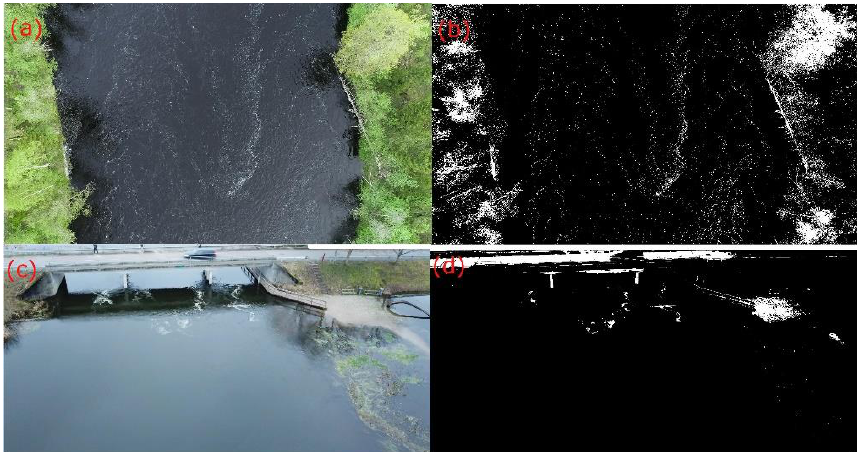
Figure 3. The image segmentation method was applied to the RGB video frames (left panel) to obtain a binary image (right panels): white color is assigned to seeding, whilst a black color is assigned to water surface (with a few outlier). ( a ) and ( b ) are in case of natural seeding (mainly foam), whilst ( c ) and ( d ) are in case of artificial seeding (woodchips).